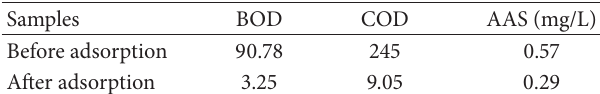
Table 5: Analytical values of TGAN before and after Ni (II)